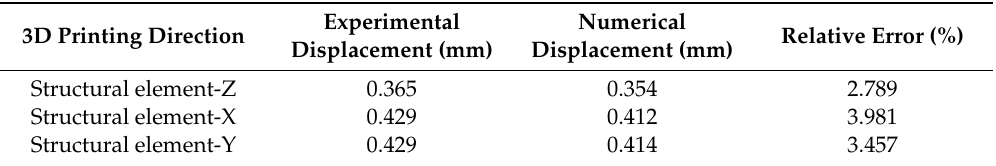
Figure 15. Field of von Mises stress obtained in the mechanical simulations. Table 12. Comparison of the experimental and numerical results obtained on the structural element under the load scenario to which it is